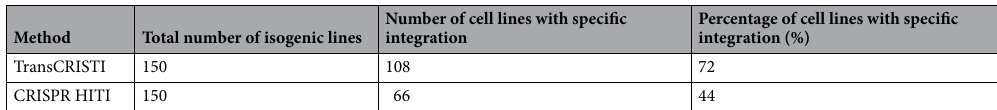
Number of cell lines with specific Percentage of cell lines with specific Method Total number of isogenic lines integration integration (%) TransCRISTI 150 108 72 CRISPR HITI 150 66 Table 1. The efficiency of site-specific insertions in the AAVS1 gene using TransCRISTI and CRISPR HITI in selected and derived clonal cell lines.